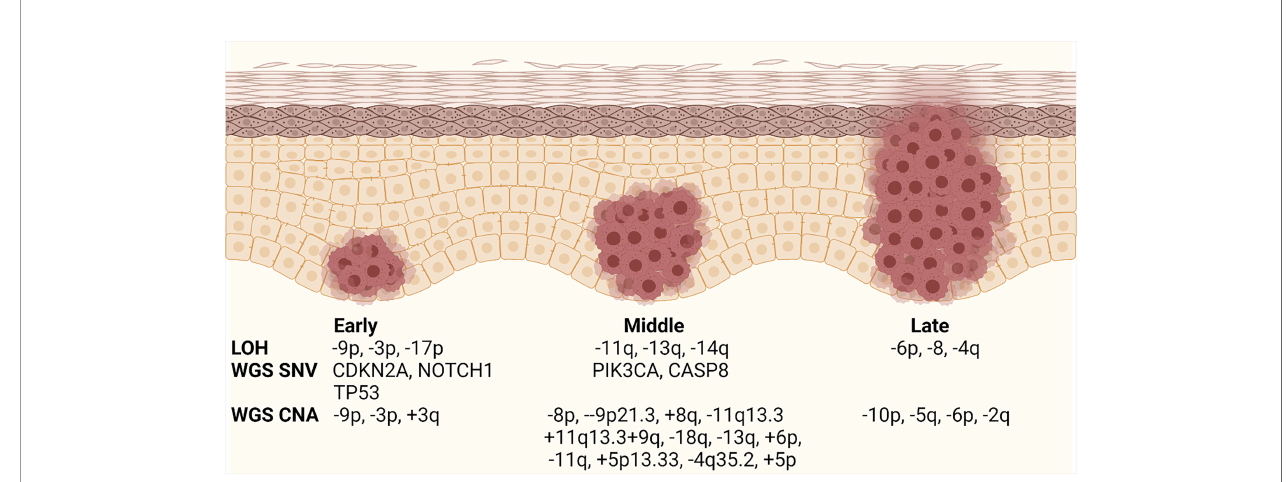
FIGURE 2 | Current OPL progression model. Schematic diagram showing the relative timing of genomic events during OPL progression. The stages are labeled early, middle, and late because the data are not well associated with speci fi c histology. LOH, loss of hetorozygosity; WGS, whole genome sequencing; SNV, single nucleotide variant; CNA, copy number alteration. Modi fi ed from Califano and Gerstung. Created with